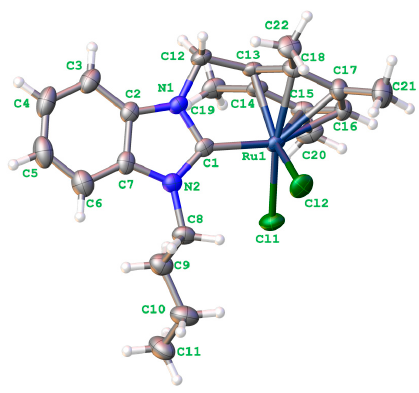
Figure 2. The molecular structure of compound 2b . Displacement ellipsoids are drawn at the 50% probability level.